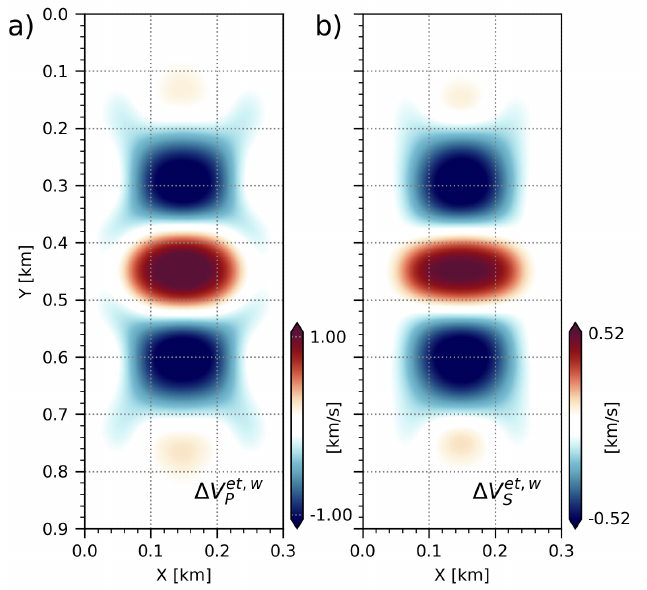
Figure 9. ( a , b ) are the inverted perturbations of P- and S-wave velocities ∆ V et , w ET objective function with wrong source wavelets when the velocity perturbations are ± 30% of the background